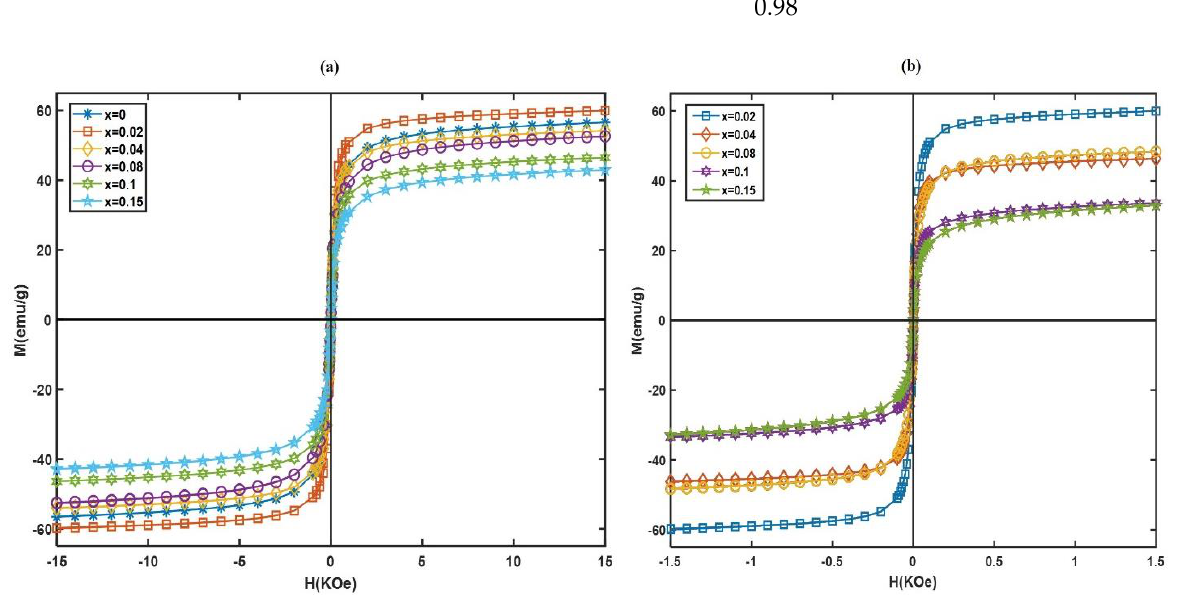
Figure 6. M-H curves of dry powders for Mn 0.6 Zn 0.4 Eu x Fe 2 − x O 4 ( x = 0.00, 0.02, 0.04, 0.08, 0.10, 0.15) with ( a ) citric acid and ( b ) pluronic F-127 coating.